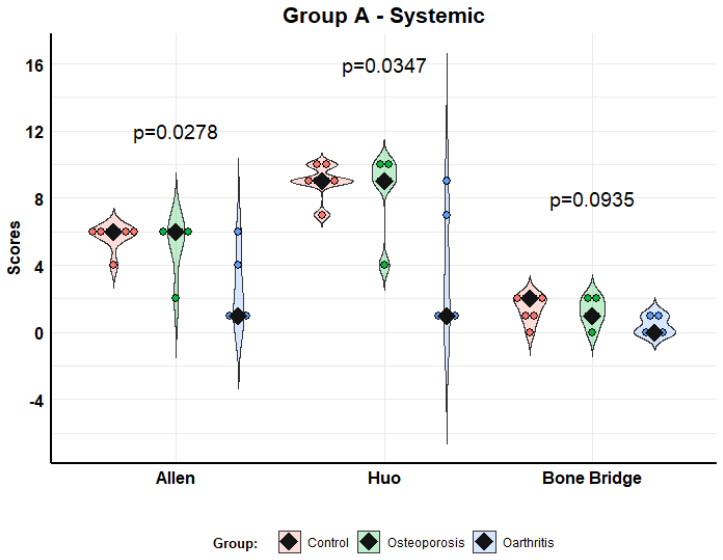
Figure 6. Histological scores according to Allen, Huo and Bone Bridge scales for Model A (systemic administration). Violin plots with individual values and medians (rhombi).